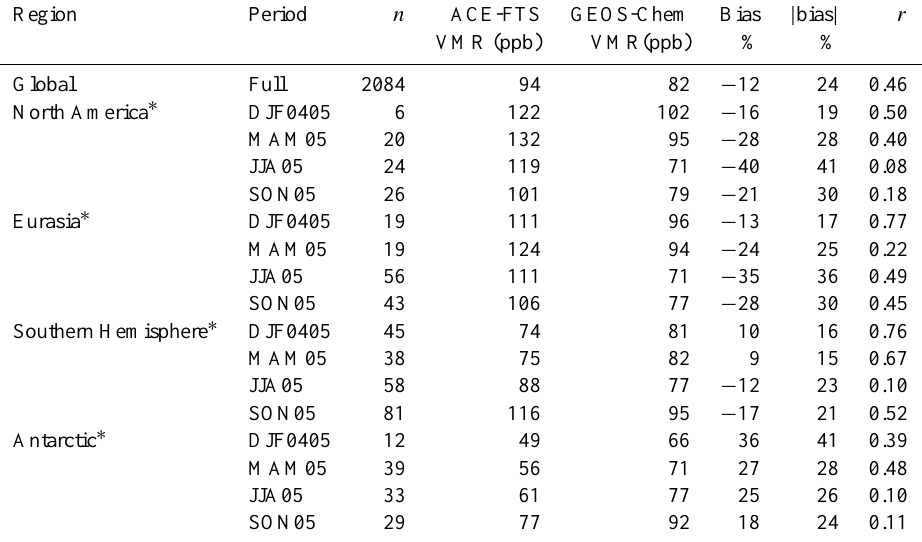
Table 2. Statistical comparison between ACE retrieved CO concentrations and GEOS-Chem output at 8.5km altitude; VMRs are expressed in ppb: n is the number of data taken into account, bias is the Mean Bias as defined by Eq. (1), | bias | is the Mean Absolute Bias as defined by Eq. (2) and r is the correlation